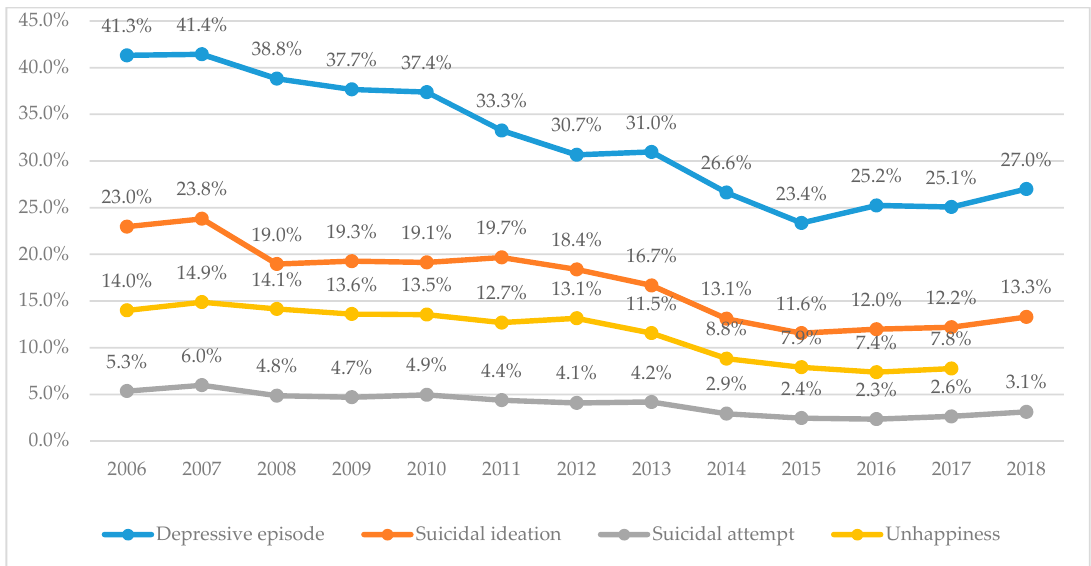
Figure 1. Changes of prevalence in adolescents’ mental health.